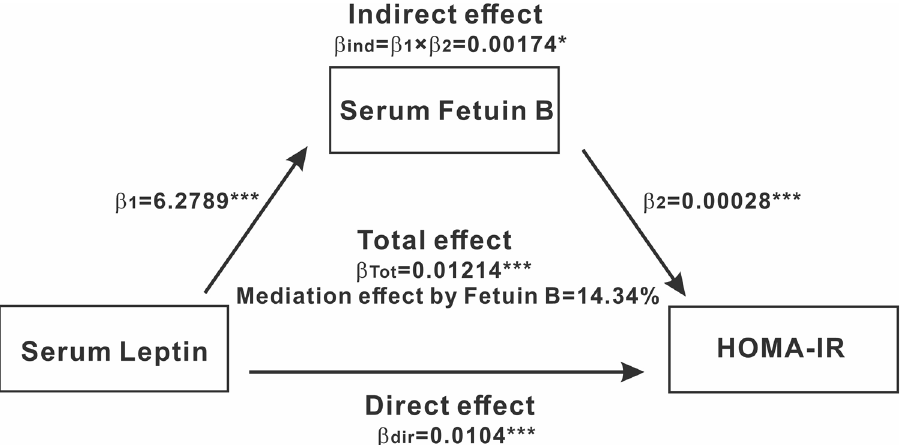
Figure 5. Leptin induces insulin resistance via Fetuin B. Mediation effects of serum Fetuin B on the association between serum leptin and HOMA-IR in obesity (n = 215). Sobel test was applied. Significance is presented as * p < 0.05, *** p < 0.001, and p < 0.05 for coefficients different from